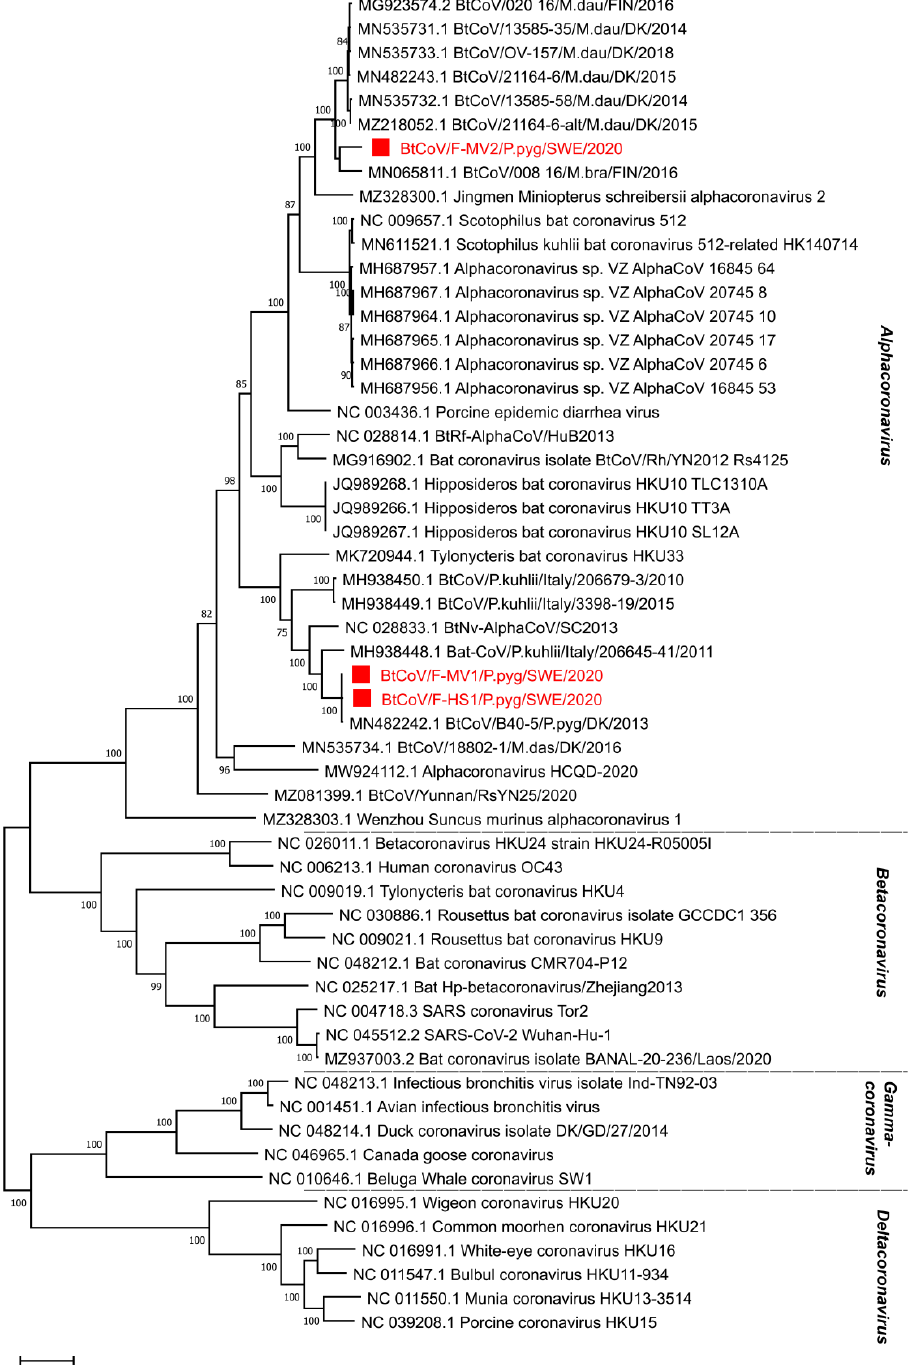
Figure 3. Phylogenetic analysis of coronaviruses from Sweden based on predicted full-length ORF1ab protein. The sequences reported in this study, BtCoV/F-MV1/P.pyg/SWE/2020 (ON457560), BtCoV/F-MV2/P.pyg/SWE/2020 (ON457561), and BtCoV/F-HS1/P.pyg/SWE/2020 (ON457562), (indicated by red square boxes and red text), and the closest sequence matches from Genbank and ICTV reference sequences from each genus within the Orthocoronavirinae subfamily are included in the analysis. The tree was generated using a maximum likelihood model with 500 bootstrap iterations on ClustalW-aligned amino acid sequences, with a total of 8037 amino acid positions in the final dataset. Only bootstrap values above 50 are displayed on the